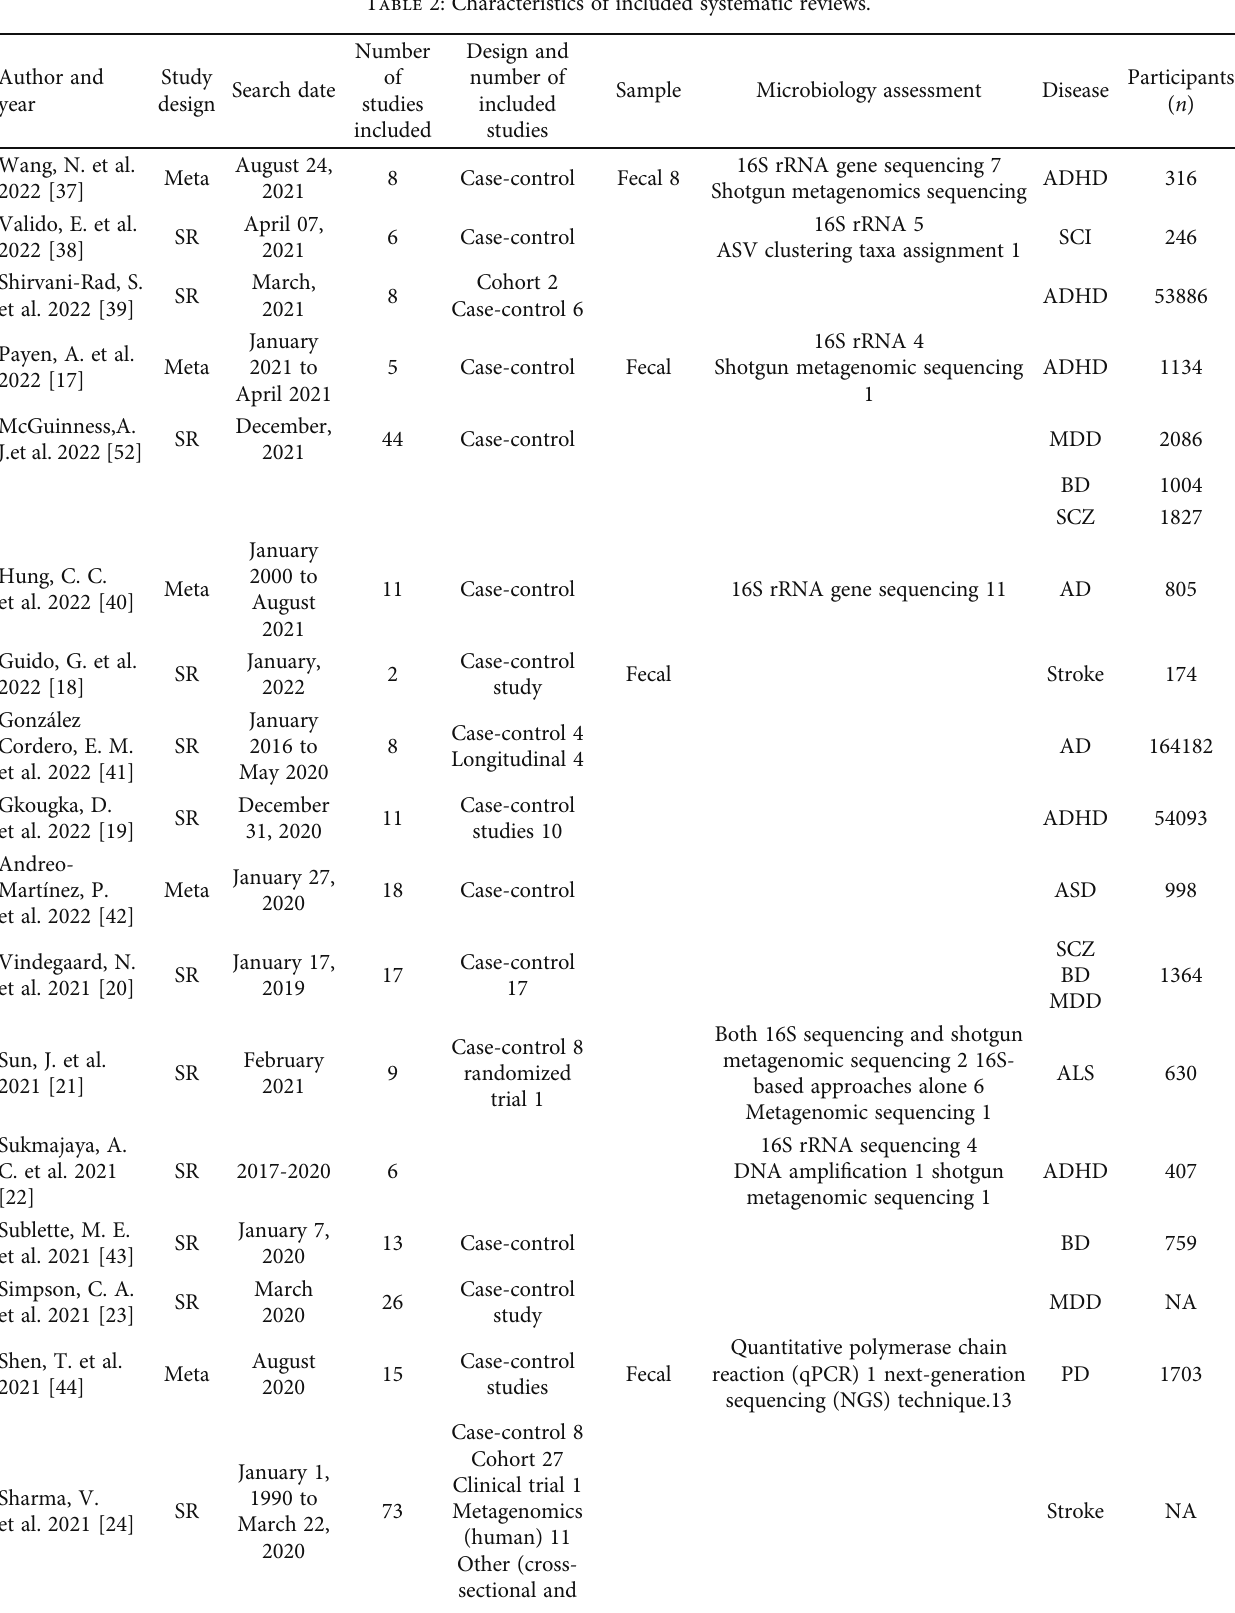
Table 2: Characteristics of included systematic